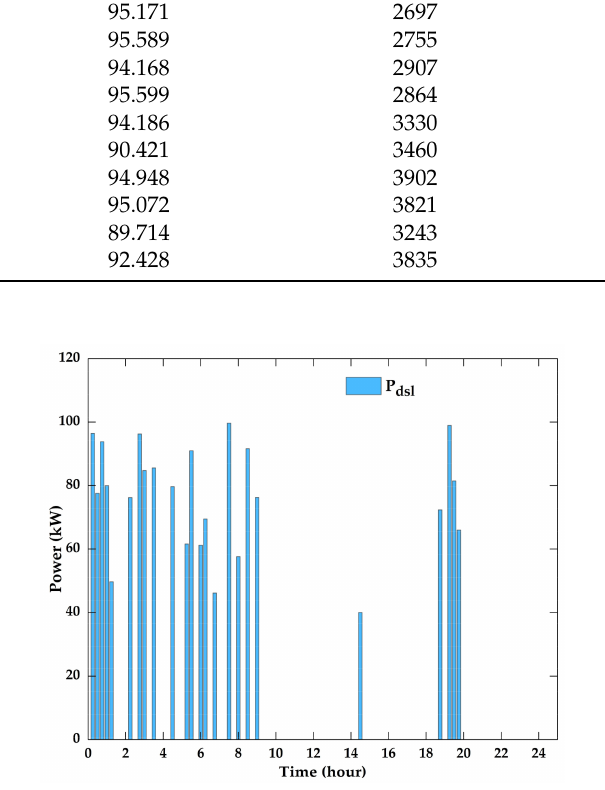
Figure 17. Diesel generator power.